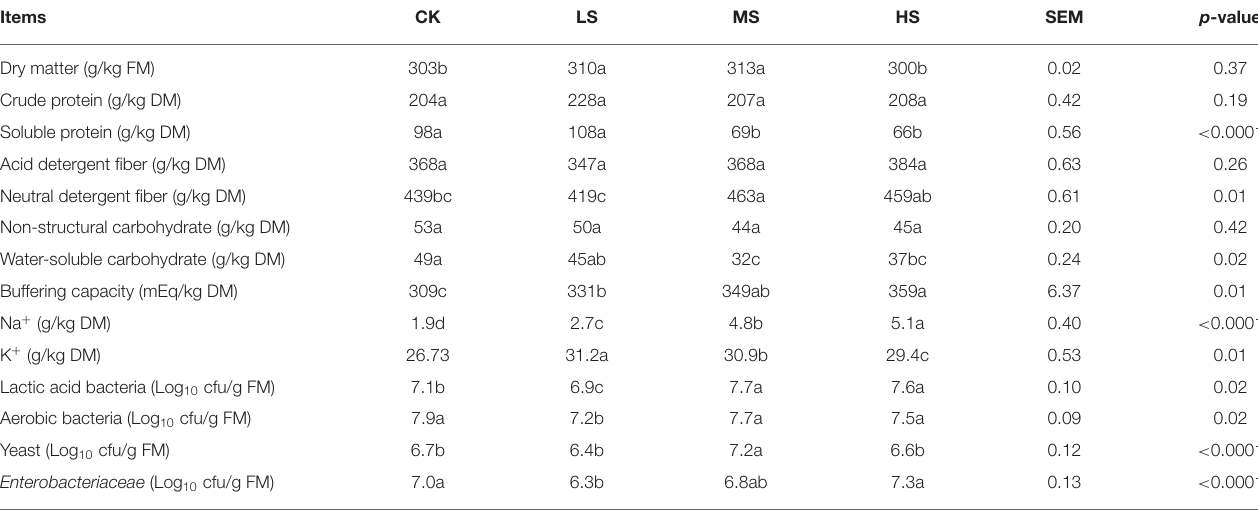
TABLE 2 | Chemical composition and microbial populations of the fresh alfalfa.